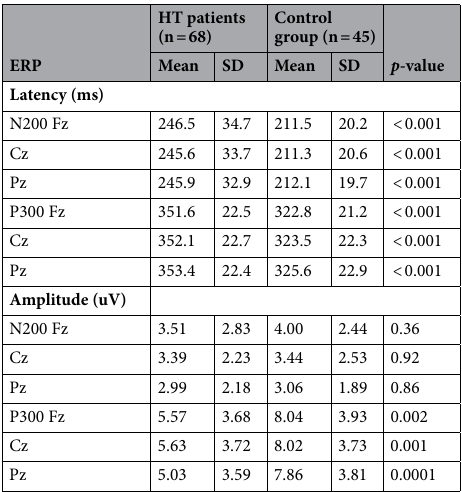
Table 2. The mean value of the latency (ms) and amplitude (uV) of N200 and P300 potentials in patients with HT and in the control group. ERP event-related potential, HT Hashimoto’s thyroiditis, SD standard deviation, Fz frontal region, Cz central region, Pz parietal region.